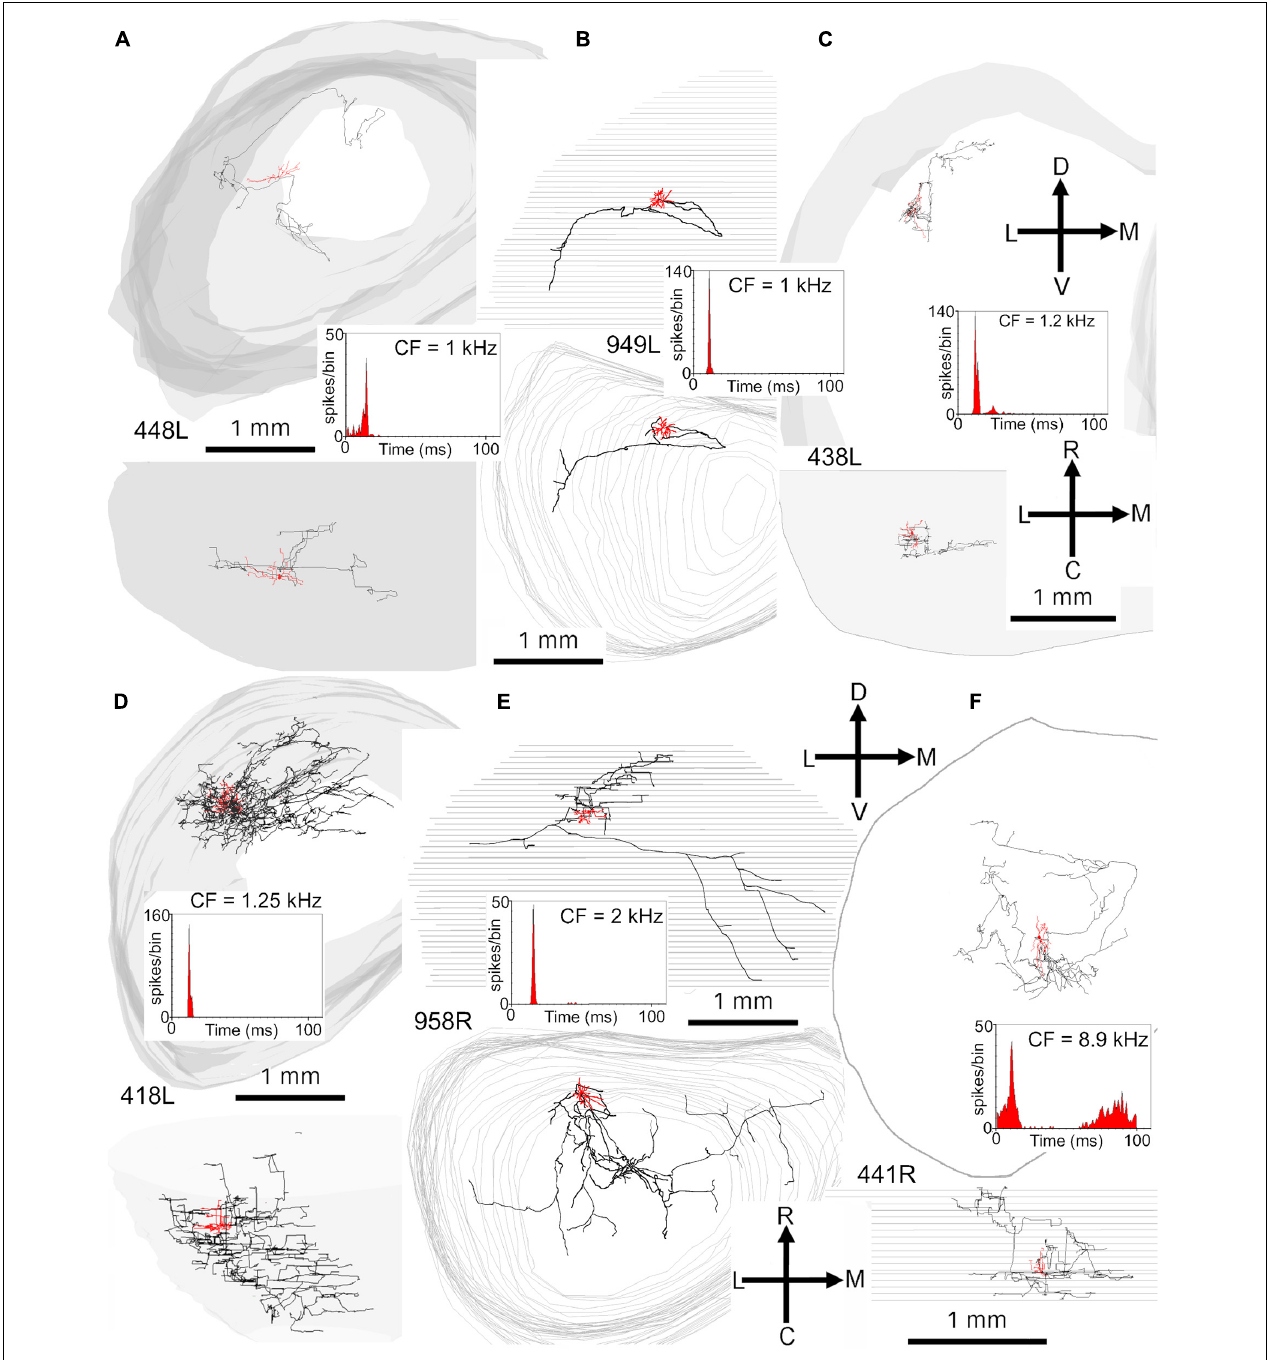
FIGURE 6 | Reconstructions of the axonal ramifications of six onset cells with somata located in the ICc. Soma and dendrites are colored red, the axon is black and the surface contours are gray. Each reconstruction is shown in the coronal and horizontal planes and portrayed as though it was on the left side of the brain, as indicated by the orientation arrows. An inset shows the PSTH in response to a 50 ms long tone pip presented binaurally at 20 dB above threshold at CF. The cells are arranged in tonotopic order. The same description applies to the next three figures as well. (A) Disk shaped, laminar (less flat) cell with axonal branches in the LC and ICc that traverse the fibrodendritic laminae. (B) Spherical stellate cell located toward the rostral edge of the ICc with a few sparse branches that terminate at two locations in the ICc. (C) Spherical stellate cell with long dendrites that extend over at least three laminae and axonal processes within at least two of these laminae. (D) Spherical stellate cell located at the lateral edge of the ICc with multiple branches that terminate extensively in the LC and ICc. (E) Spiny, disk shaped laminar (less flat) cell located in the rostral part of the ICc, with an axon that mainly terminates in a fibrodendritic lamina, that is dorsal to the soma, but also gives off other branches in traveling toward the commissure. (F) Spherical stellate cell, with a large soma located in the rostral part of ICc, with an axon that has extensive branches within ICc.